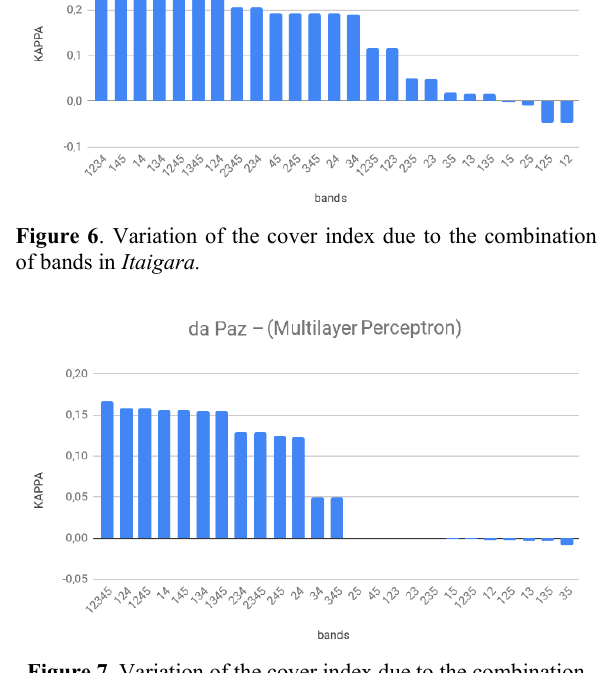
Figure 7 . Variation of the cover index due to the combination of bands in da Paz